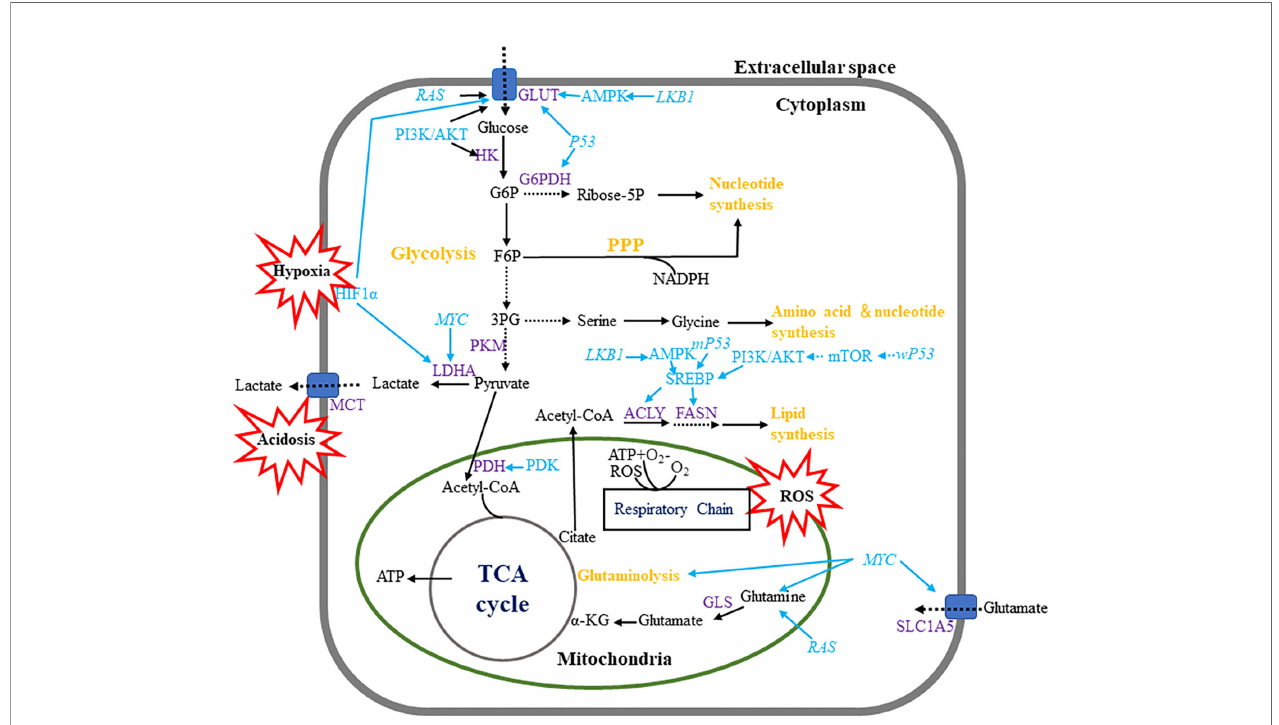
FIGURE 1 | Metabolic pathways in breast cancer cells. Breast cancer cells enhance metabolism of glucose, amino acid lipid by regulating multiple metabolic pathways. Breast tumor cells mainly use aerobic glycolysis to produce ATP and utilize the pentose phosphate pathway to produce macromolecules such as NADPH. Wild-type and mutant P53 have contrary effects in monitoring fatty acid metabolism. Hypoxia, acidosis and ROS are regarded as important events which in fl uence multiple metabolic